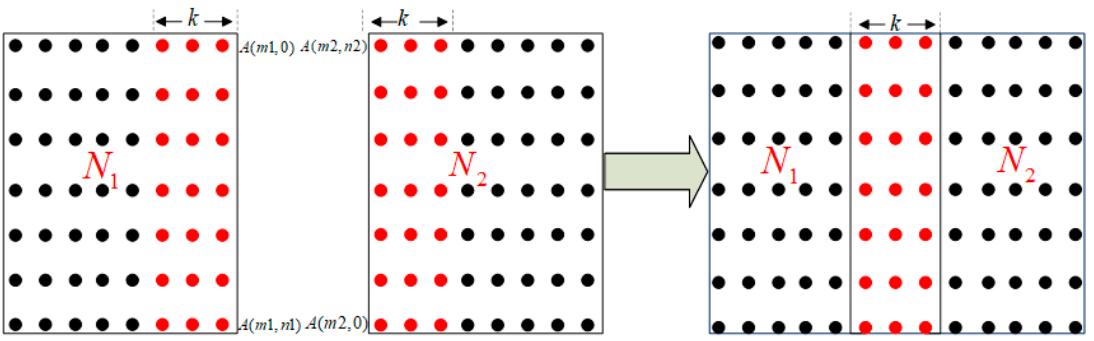
Figure 6. Schematic diagram of point cloud registration.